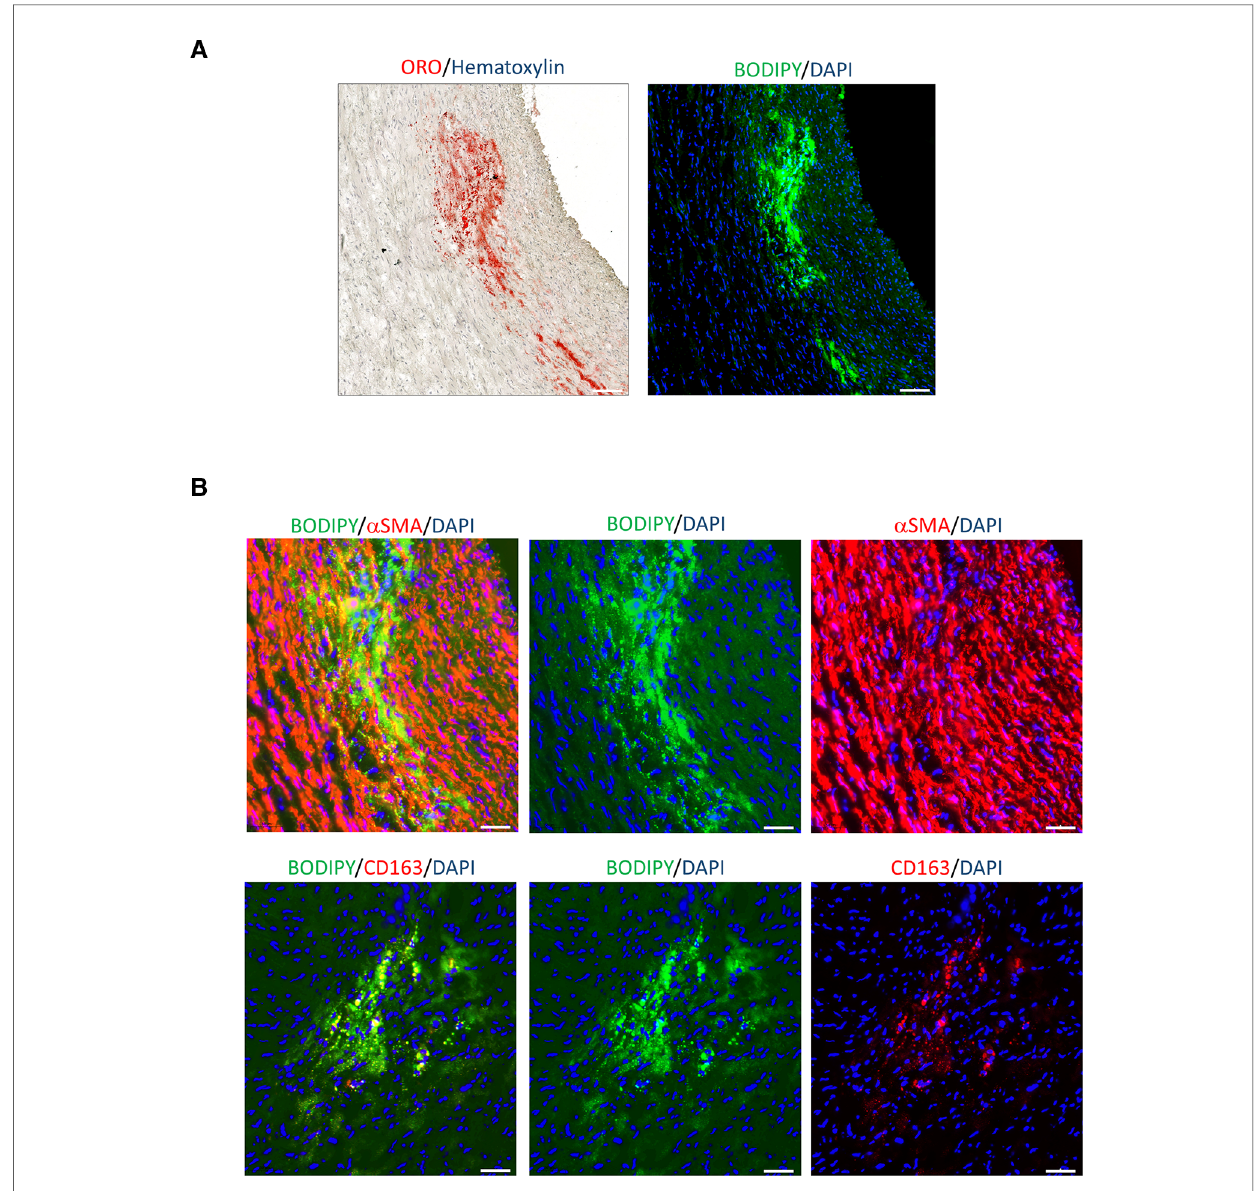
FIGURE 6 Lipid clusters localised mainly in vSMCs. ( A ) Comparison of lipid cluster distribution at the injured site by ORO staining and lipophilic fl uorescent probe, BODIPY TM 493/503 (green). Nuclei DAPI (blue). Scale bar: 100 µm. ( B ) Co-staining analysis of the indicated tissue section with BODIPY TM 493/503 and α SMA or CD163 (red). Images indicate all markers and individual channel. Scale bar: 50 μ